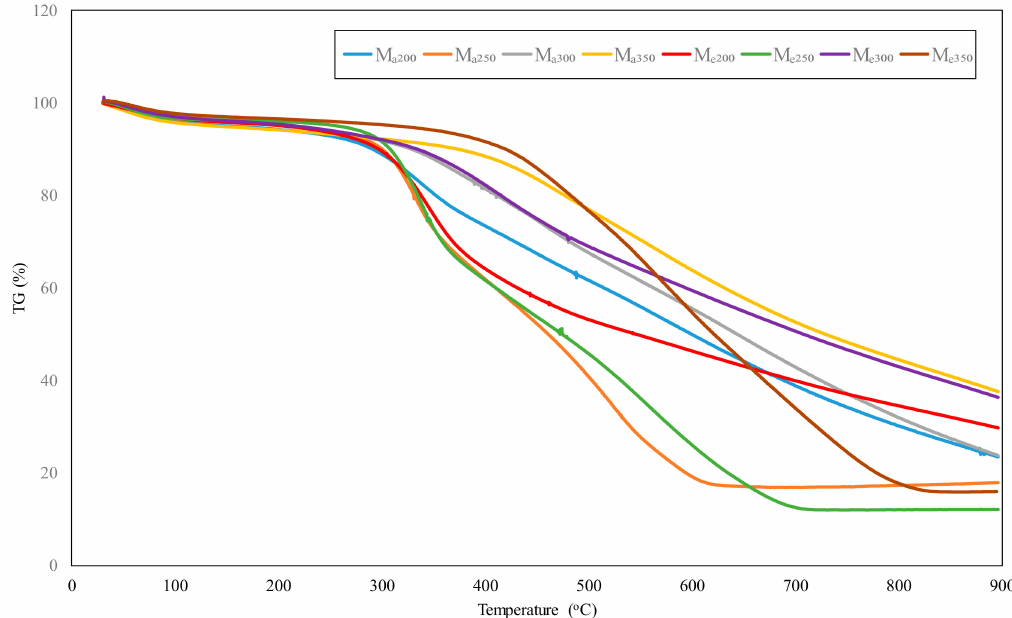
Figure 2. Thermogravimetric analysis (TGA) curves of torrefied sewage sludge and sugarcane bagasse